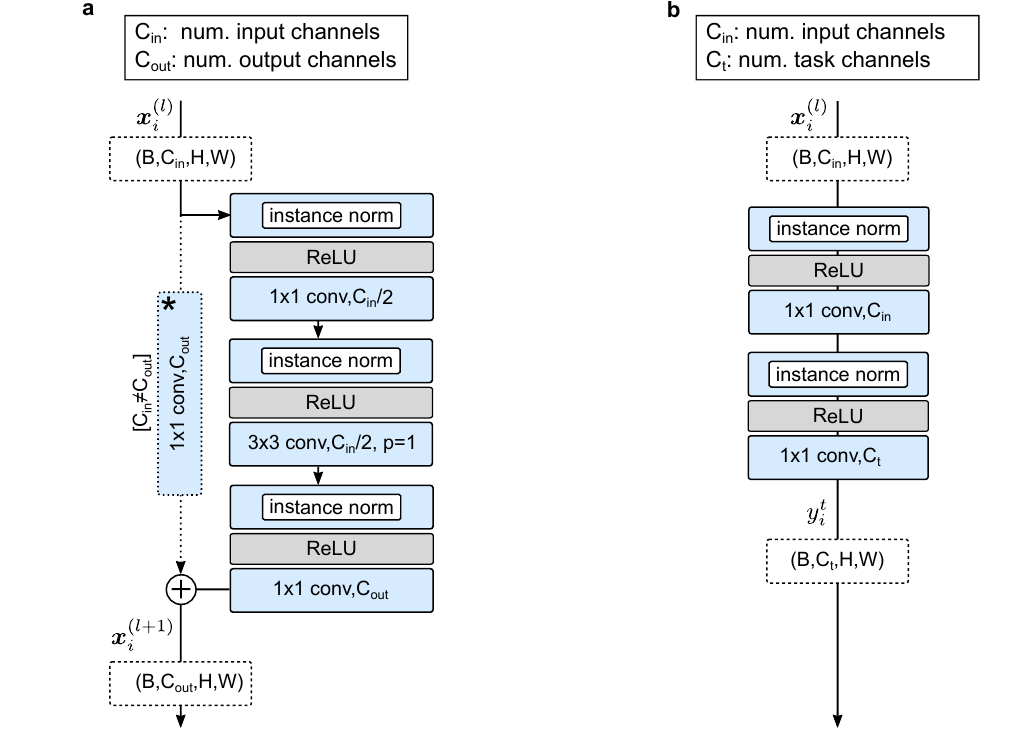
Figure A3. Topology of utilized neural network building blocks based on the work from Newell et al. [76] and He et al. [77]. ( a ), layout of 3-layer pre-activation bottleneck with identity mapping [77]. If the number of input and output channels is different, the identity function is replaced by a 1 × 1 convolution. ( b ), task heads which output C t predictions. (p: padding, ⊕ : feature fusion by element- wise